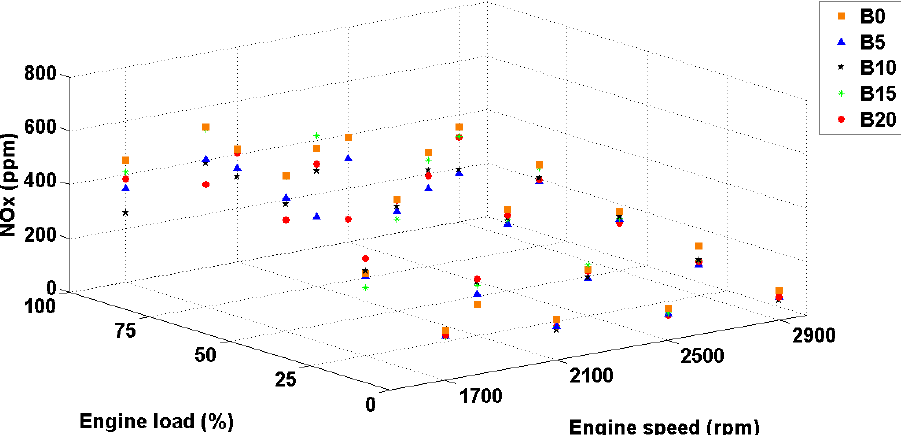
Figure 18. NOx emission of the engine in different engine load, speed and biodiesel percent.